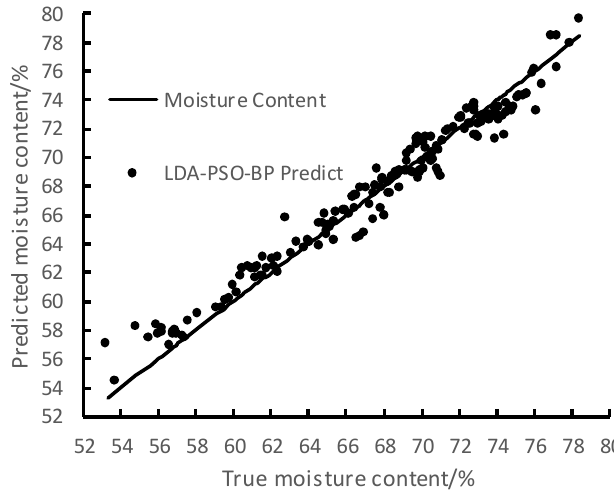
Figure 8. PCA-GA-BP model prediction scatter plot.